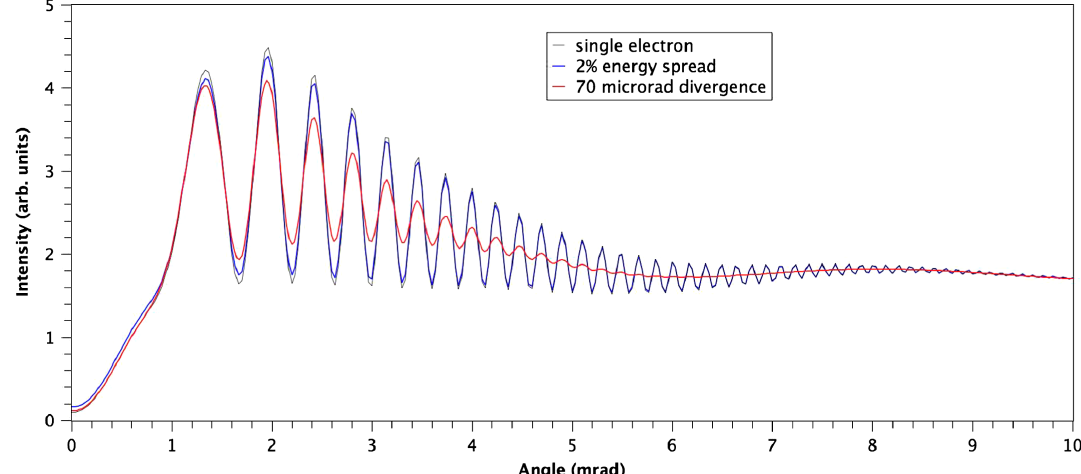
FIG. 12. OSR interferences from magnets (2,3) and a beam energy of 286 MeV showing the fringe visibility for single electron (black line); a beam with (a) 5.7 MeV rms energy spread (blue line); and a beam with an angular divergence of 70 μ rad (red line).